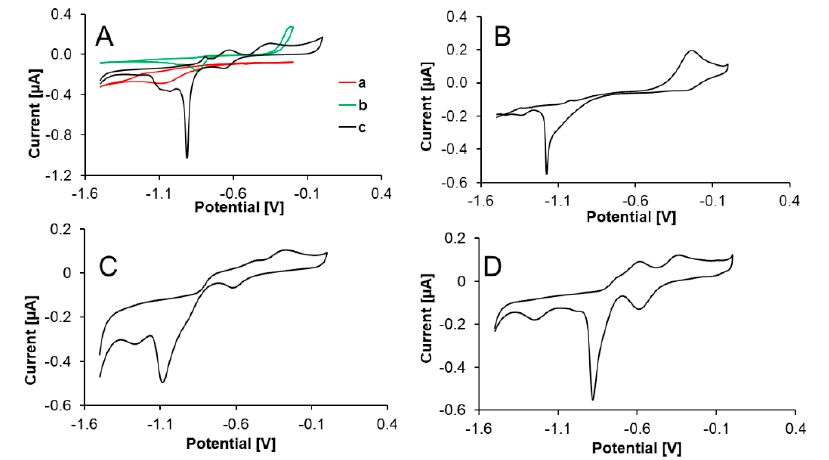
Figure 1. (A ) Cyclic voltammogram of a : Blank (buffer composed of 1.750 mL H 2 O + 100 µ L of the mixture (1 M HCl + 3 M NH 3 )), b : Ni 2+ 250 ppb, c : ttc 5 × 10 − 4 M, ( B ) CV of ( 1 ), 5 × 10 − 4 M, ( C ) CV of ( 2 ), ( D ) CV of ( 3 ), 5 × 10 − 4 M. CV parameters: start potential − 1.5 V, final potential 0.0 V, scan rate 50 mV · s − 1 . Materials 2018 , 12 , x FOR PEER REVIEW 4 of 8